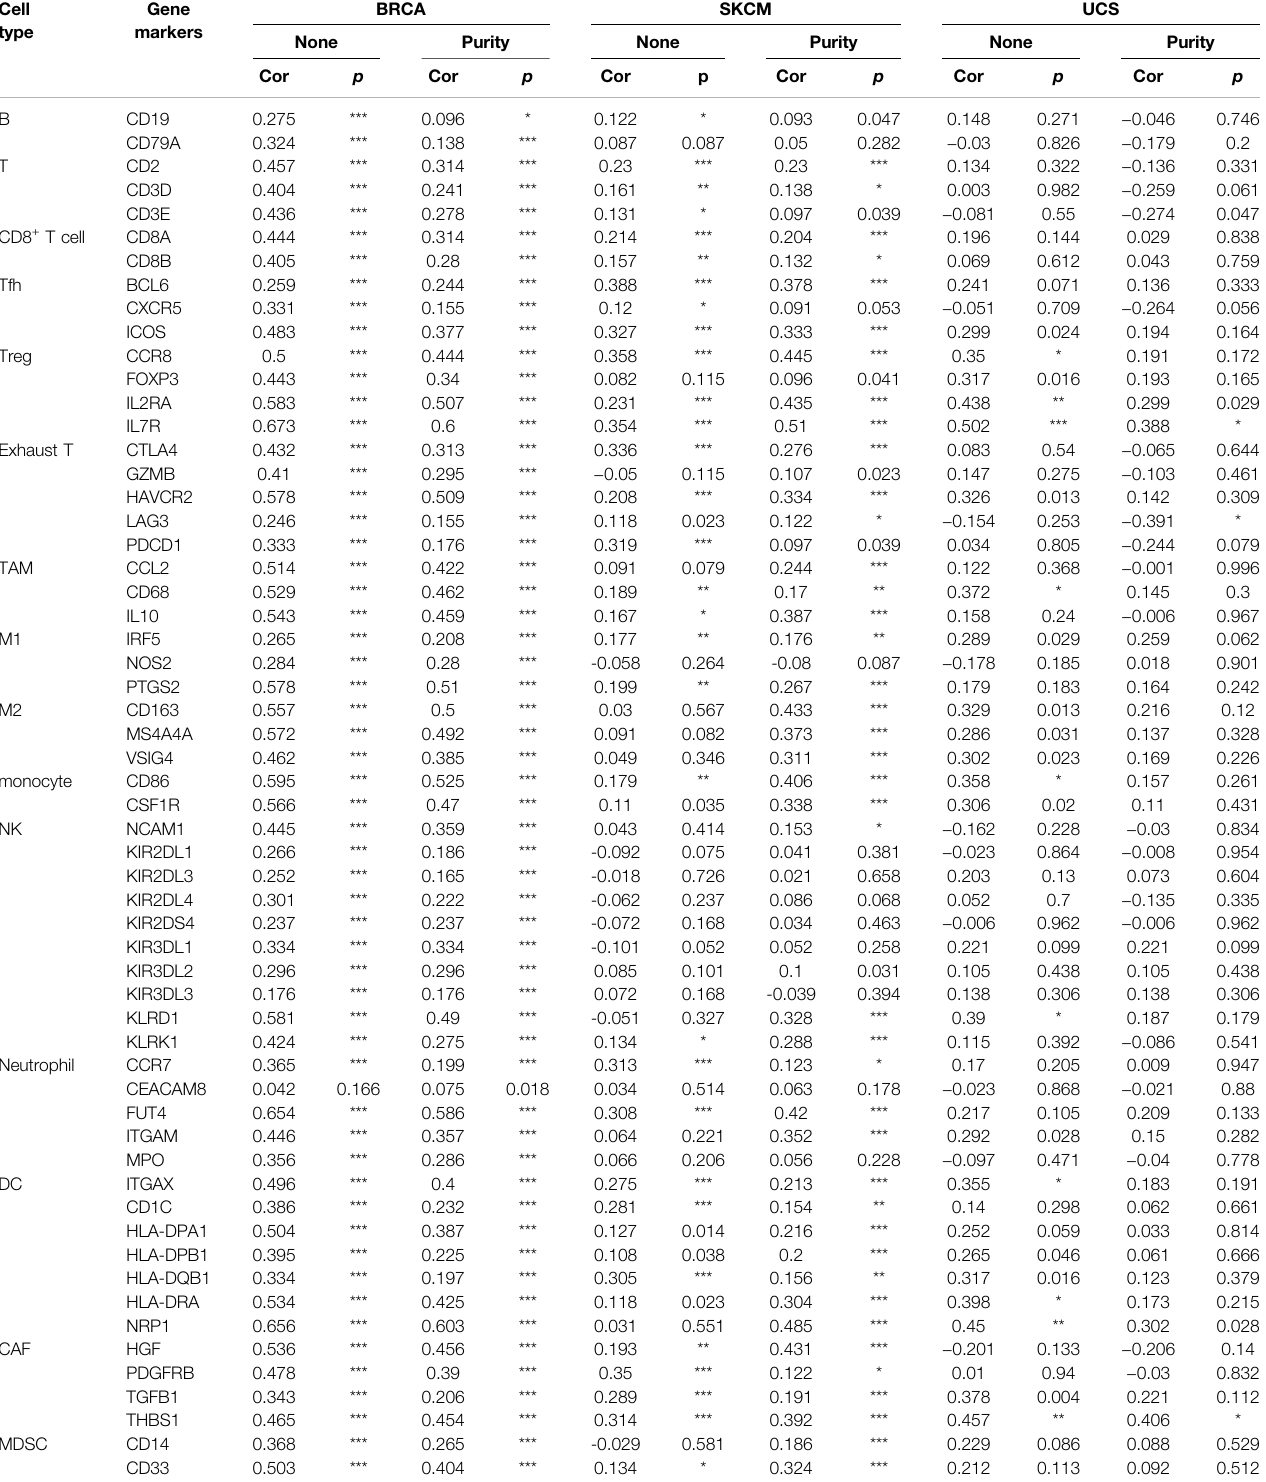
TABLE 1 | Correlations between ACSL4 and gene markers of immune cells in TIMER. Cell